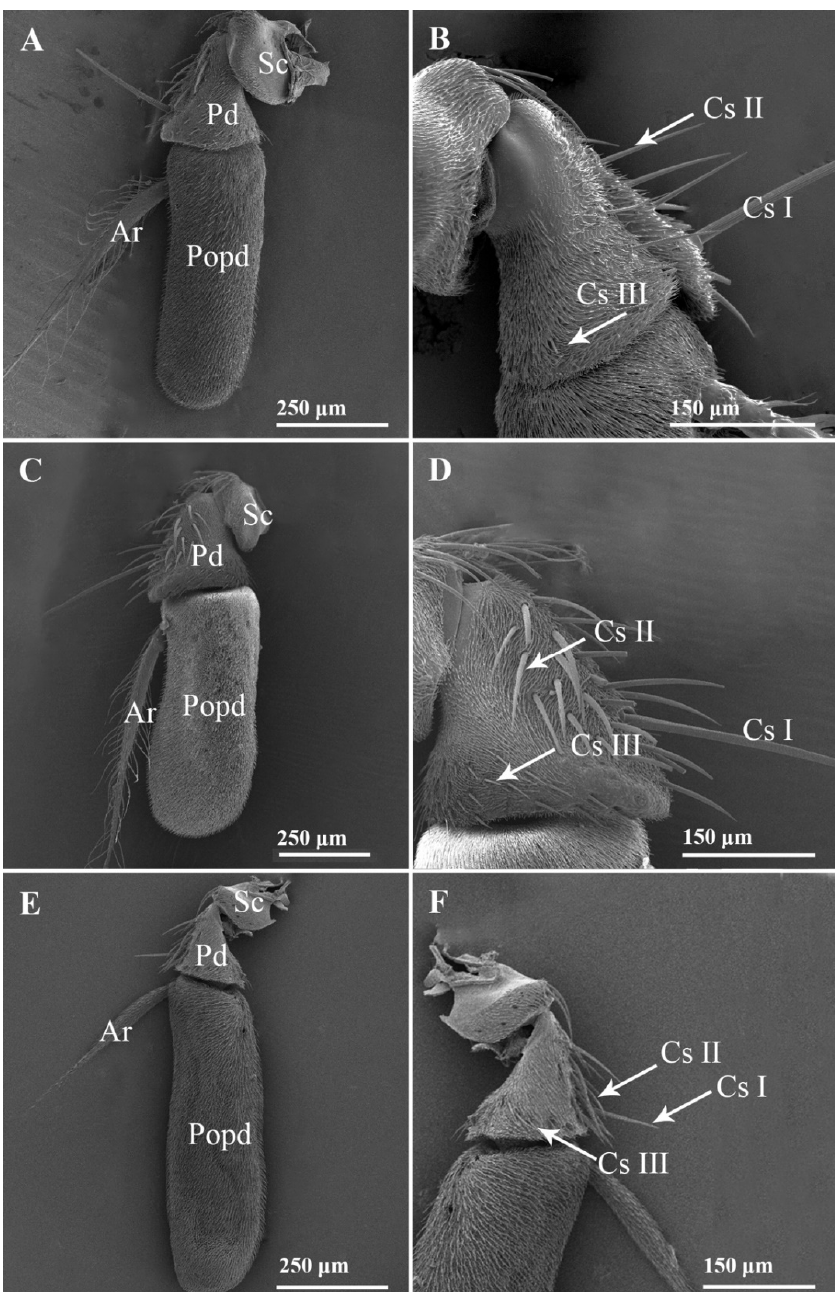
Figure 1. Features on the antennae of male Sarcophaga portschinskyi , Agria mihalyii , and Metopia campestris . ( A ) S . portschinskyi , ( C ) A . mihalyii , and ( E ) M . campestris antenna, showing the anterior surface; ( B ) S . albiceps , ( D ) A . mihalyii , and ( F ) M . campestris , showing three subtypes of mechanorecep- tors on the antennal pedicel. Abbreviations: Cs I (subtype I chaetic sensilla); Cs II (subtype II chaetic sensilla); Cs III (subtype III chaetic sensilla); Ar (arista); Popd (postpedicel); Pd (pedicel); Sc (scape). Four to nine setiferous plaques (Pl) are distributed in a slightly elevated and smooth area between Cs II and Cs III on the pedicel (Figure 2A,C,E,G,I). Each setiferous plaque contains a bulbous seta with a sharply abrupt tip slightly extended to an obtuse base that is inserted in a socket with an elevated rim (the bulbous setae are lost, probably due to age, in Figure 2B,J), with a cluster of microtrichia and few micropores at the base (Figure 2B,D,F,H,J). One pedicellar button (PB) located within the dorsal recess and near the pedicellar cleft can be discovered after separating the pedicel and the postpedicel (Figure